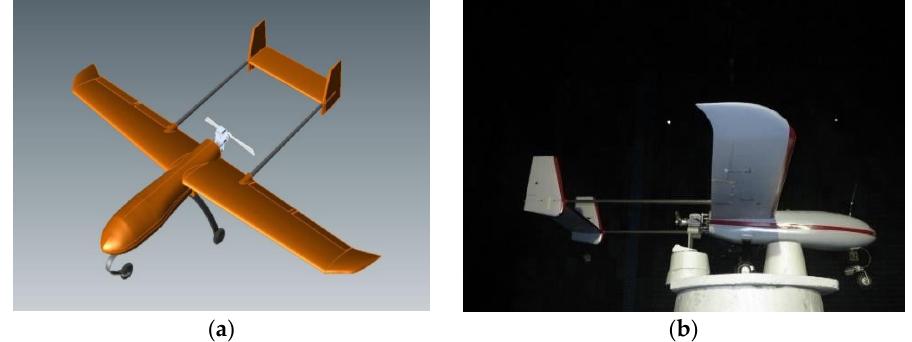
Figure 10. UAV model and measurement scene in the anechoic chamber: ( a ) Pioneer UAV model; ( b ) Measurement scene in the anechoic chamber.